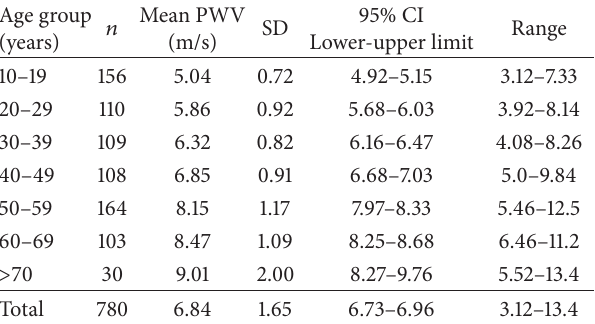
Table 2: Carotid-femoral PWV for each age group in the examined